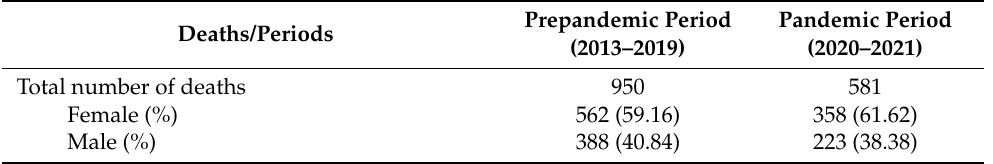
Table 1. Demographic characteristics of rheumatic-disease patient cohort’s death cases in the prepan- demic and pandemic